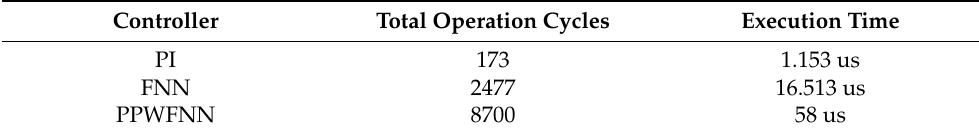
Table 2. Compute time of PI-, FNN- and proposed PPWFNN-controlled BESSs.